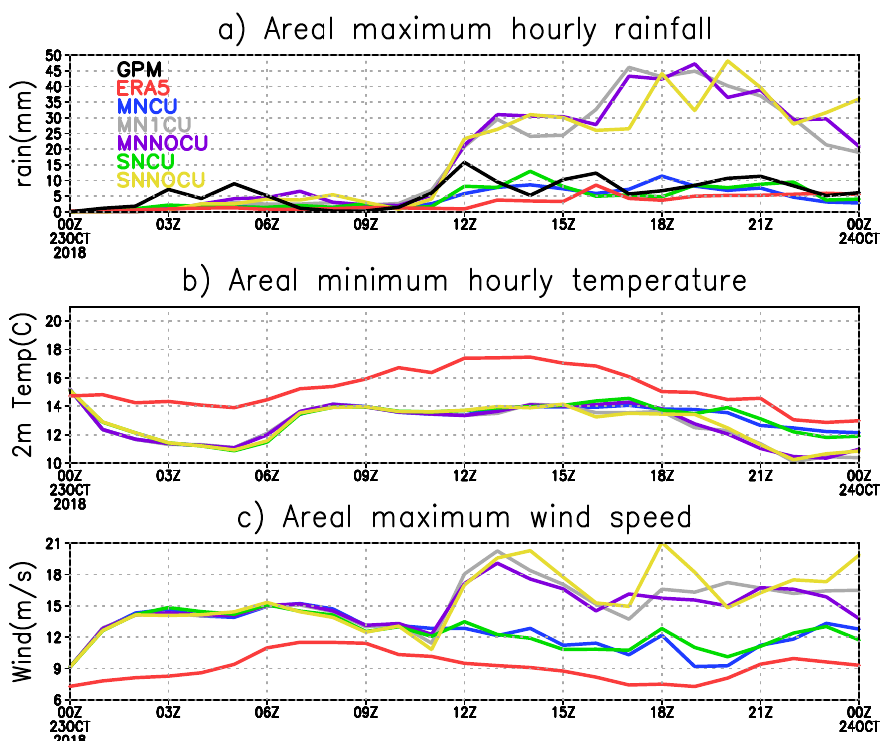
Figure 7. ( a ) shows hourly simulated maximum rainfall between 14 ◦ and 17.3 ◦ E and 22 ◦ and 18 ◦ S (area represented by purple rectangle in Figure 3) by different WRF configurations and the predicted ERA5 rainfall, as well as GPM rainfall estimate. The remaining plots show hourly ( b ) areal minimum temperature, ( c ) areal maximum wind speed from 00 h 00 UTC on 23 October to 00 h 00 UTC on 24